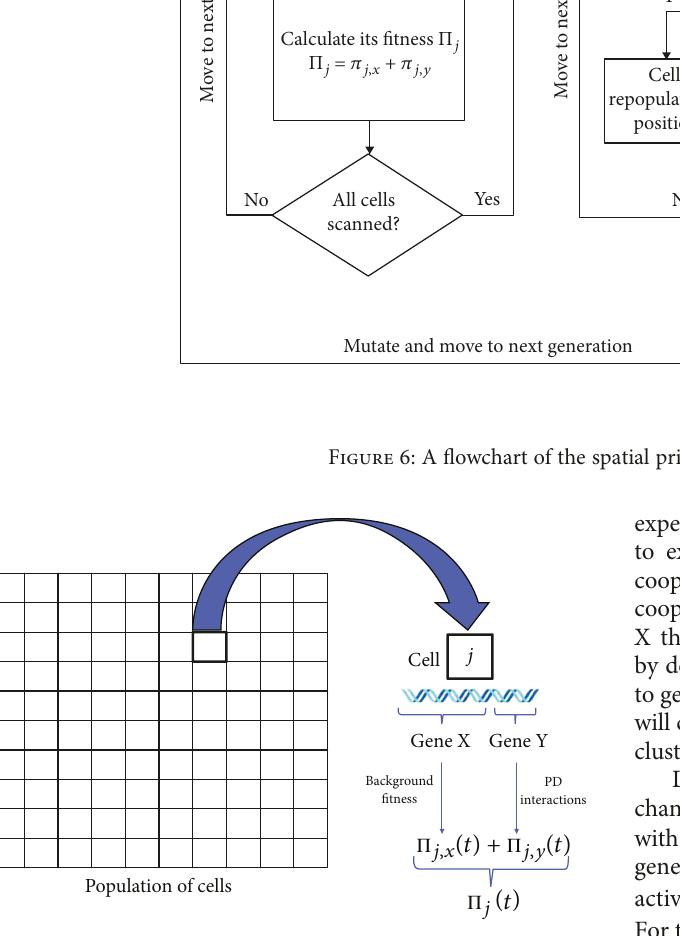
Figure 7: Each cell in the grid has two sources of fi tness. π t is j ,Y the familiar fi tness function resulting from the PD interactions with neighbor cells. Additionally, there is π t which represents j ,X the contribution in fi tness from all the other genes of the cell, aggregated as gene X. All cells in the grid are assigned the same background fi tness at the beginning of the simulation, with π t = 0 = 0 for any cell j in the grid. j ,X